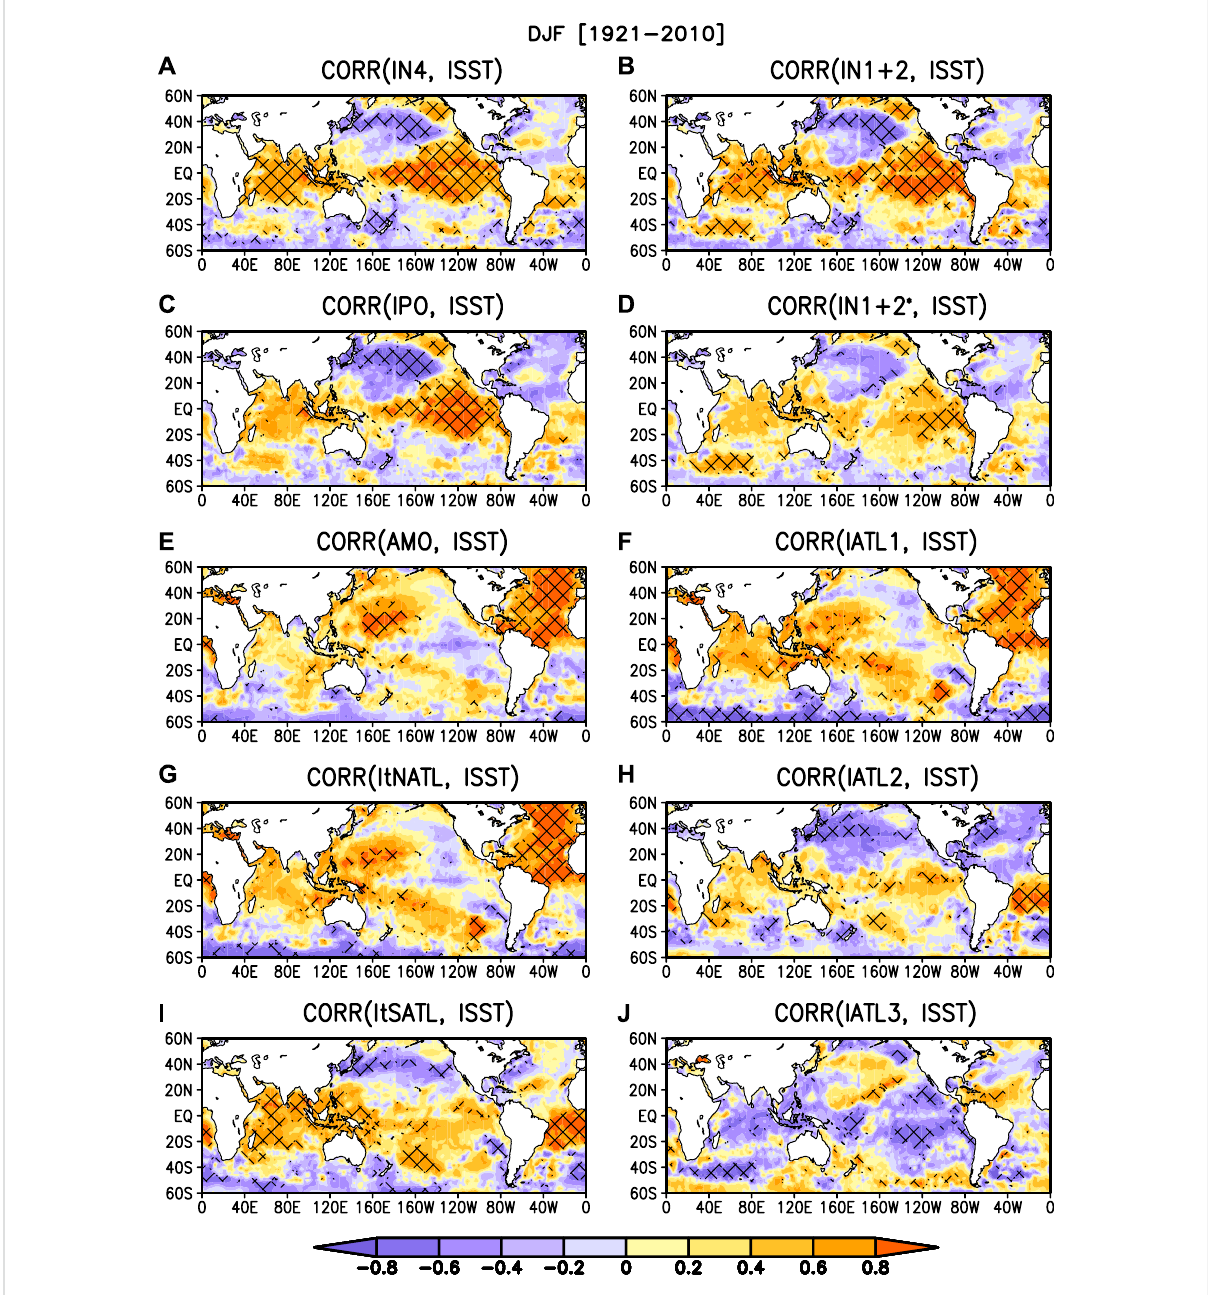
FIGURE 3 Spatial correlation of the interdecadal component of the sea surface temperature (ISSTA) anomalies (ISSTA, C ° ) with (A) Interdecadal Niño 4 (IN4) index, (B) Interdecadal Niño 1 + 2 (IN1+2) index, (C) Interdecadal Paci fi c Oscillation (IPO), (D) Interdecadal Niño 1 + 2 with Niño 4 removed (IN1+2*) index, (E) Atlantic Multidecadal Oscillation (AMO), (F) fi rst rotated principal component of the interdecadal variability of the Atlantic SST (IATL1), (G) Interdecadal tropical North Atlantic (ItNATL) index, (H) second rotated principal component of the interdecadal variability of the Atlantic SST (IATL2), (I) Interdecadal tropical South Atlantic (ItSATL) index, and (J) third rotated principal component of the interdecadal variability of the Atlantic SST (IATL3). The analysis is based on austral summer (December-January-February, DJF) averages for the 1921 – 2010 period. Hatching represents a statistically signi fi cant correlation at the 95% con fi dence